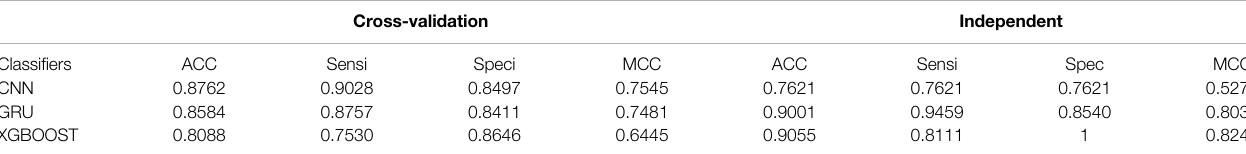
TABLE 6 | Ef fi ciency of different methods in terms of various feature extraction schemes.